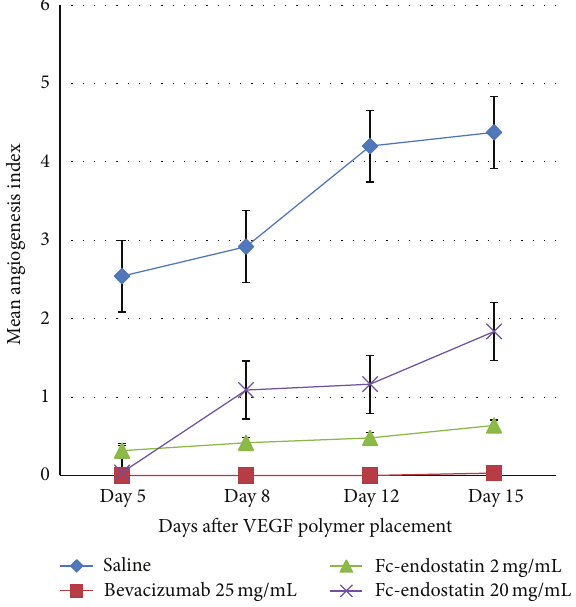
Figure 4: Inhibition of human vascular endothelial growth factor- (VEGF-) induced corneal neovascularization in rabbit. Mean angio- genesis index (AI) ± standard error of the mean (SEM) of new vessels in control and treatment groups (BV: bevacizumab; FcE: Fc-